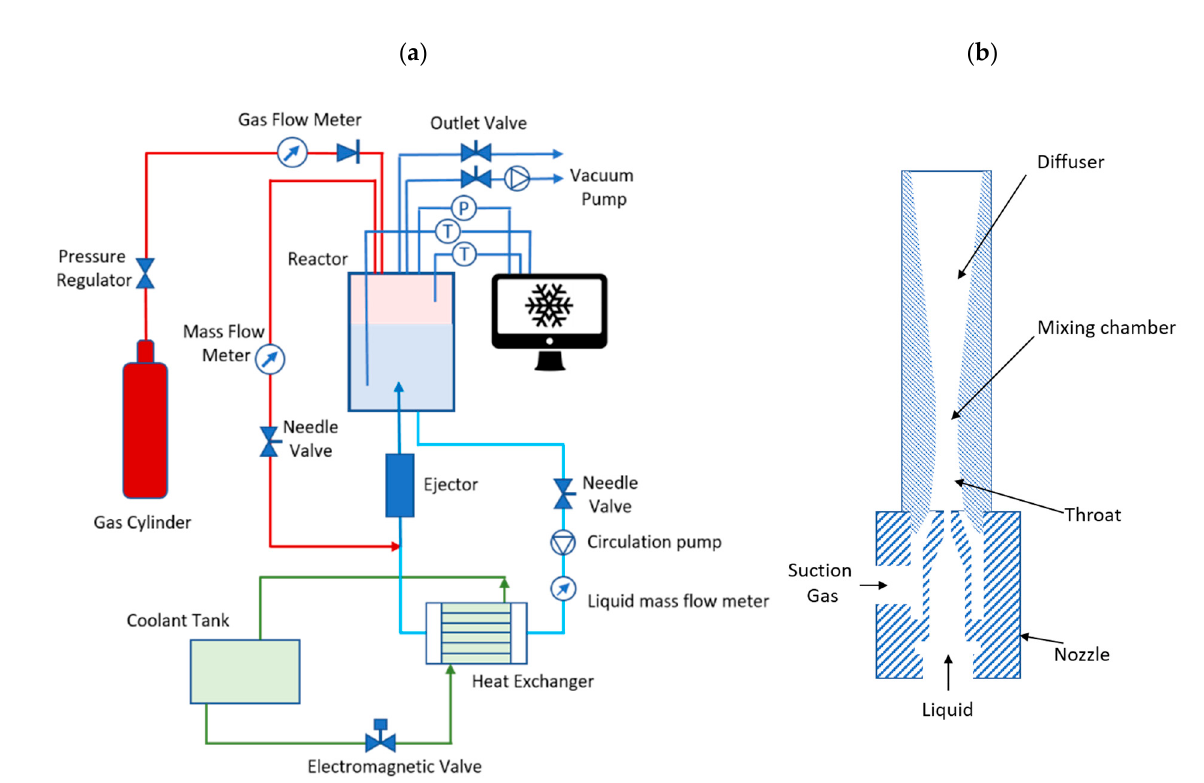
Figure 4. ( a ) Schematic plot of the hydrate formation system with ELR. ( b ) Scheme of the ejector. Therefore, Wang et al. [28] proposed a new hydrate-preparation system under an endogenous force-field. In this design, instead of a smooth tube, a tube with an internal spiral groove was used (Figure 5) to generate a secondary flow and centrifugal force (endogenous force field) [29,30]. This force-field and the existing density difference between water, gas and hydrate, will cause the removal of the formed hydrate attached to the wall. On the other hand, an enhanced degree of heat-transfer of the fluid inside the tube was observed due to the production of secondary flow phenomena that also serves to increase the extent of synergism between the velocity and temperature fields [31–33].